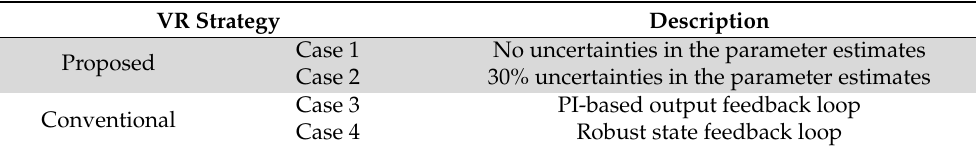
Table 9. Features of the proposed and conventional strategies.